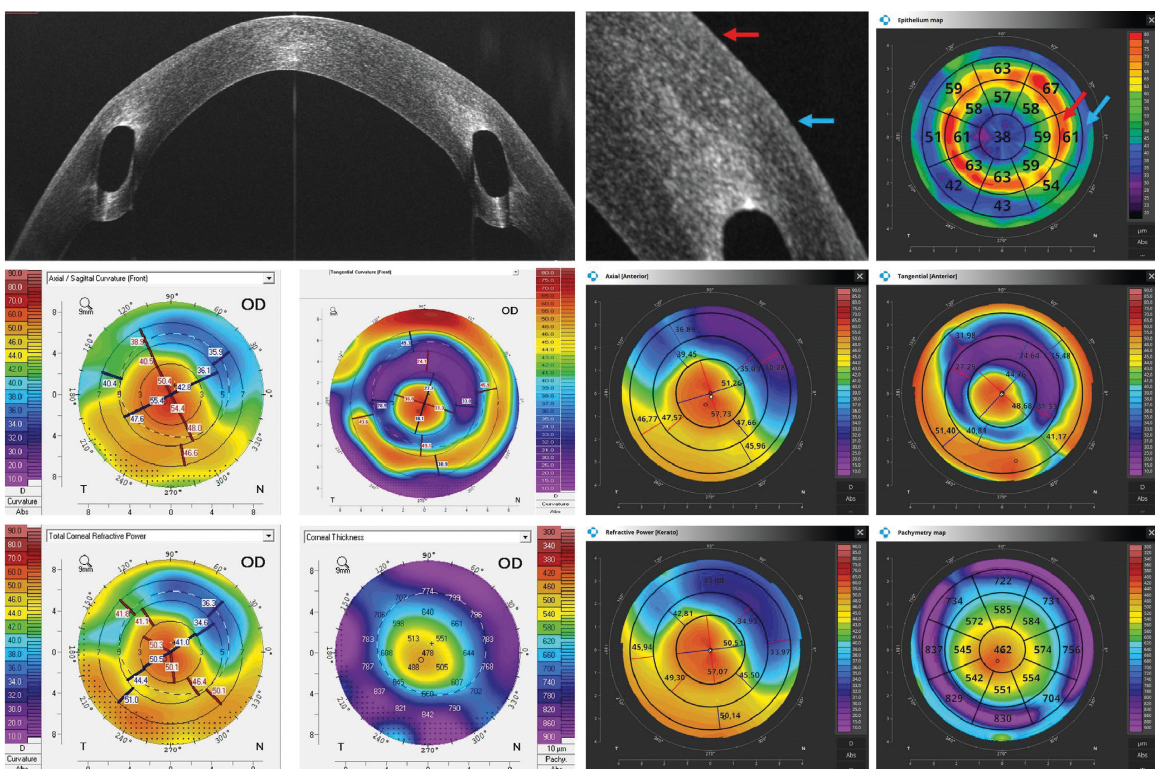
Figure 5: Cornea with an intracorneal ring segment. OCT reveals epithelial thinning immediately above the ring (blue arrow) with the thickness increasing toward the ring (red arrow). Topography maps reveal abnormalities in the anterior surface of the cornea. The measurements performed with Pentacam have a white background, and the ones performed with REVO NX have a black background. The K1, K2, and astigmatism values for the anterior surface of the cornea obtained using Pentacam are 48.9 D, 52.8D, and 4.0D, respectively, while the values obtained using REVO NX are 48.6D, 52.4D, and 3.8D, respectively. The values of analogous parameters for the posterior corneal surface from Pentacam are − 9.1D, − 9.5D, and 0.3D and the values from REVO NX are − 9.1D, − 9.7 D, and